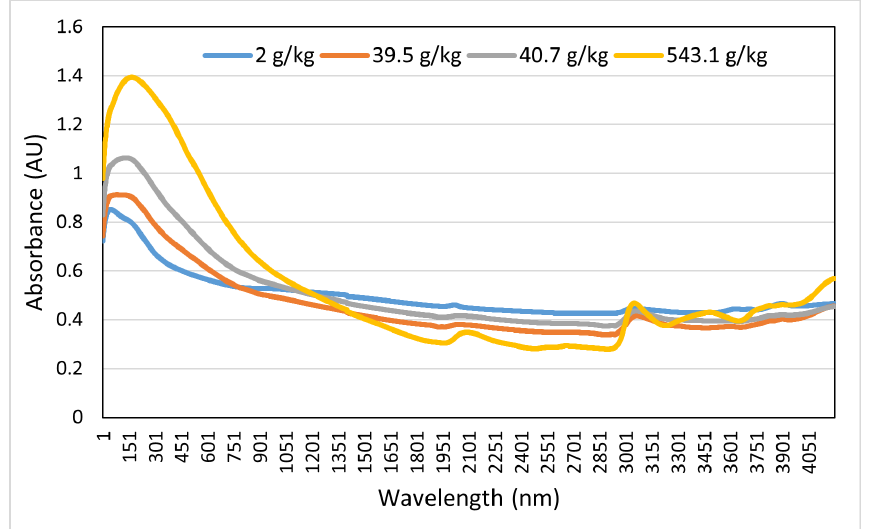
Figure 7. Absorbance of soil organic carbon in the hyperspectral band ranging from 400 nm to 2499.5